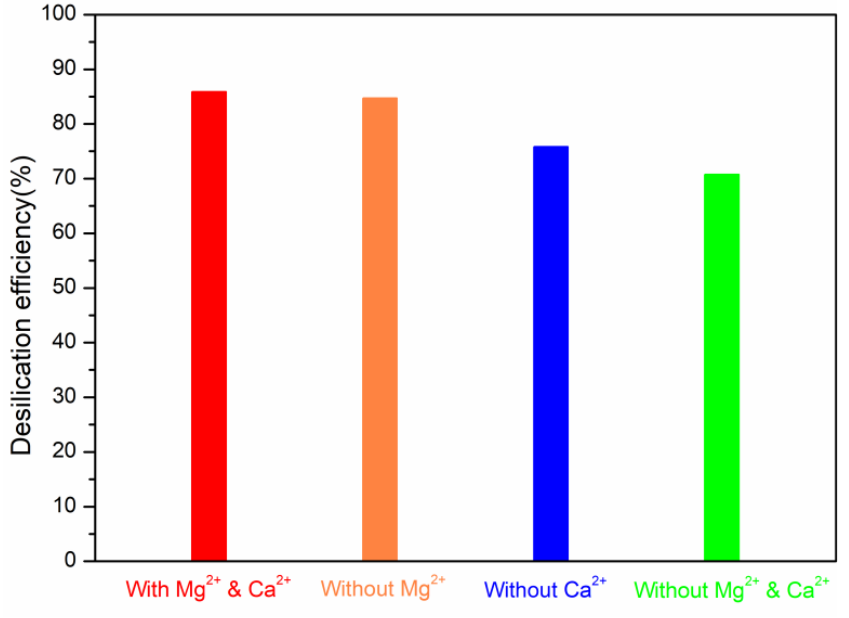
Figure 4. The impact of Ca 2+ and Mg 2+ on silicon removal rate.